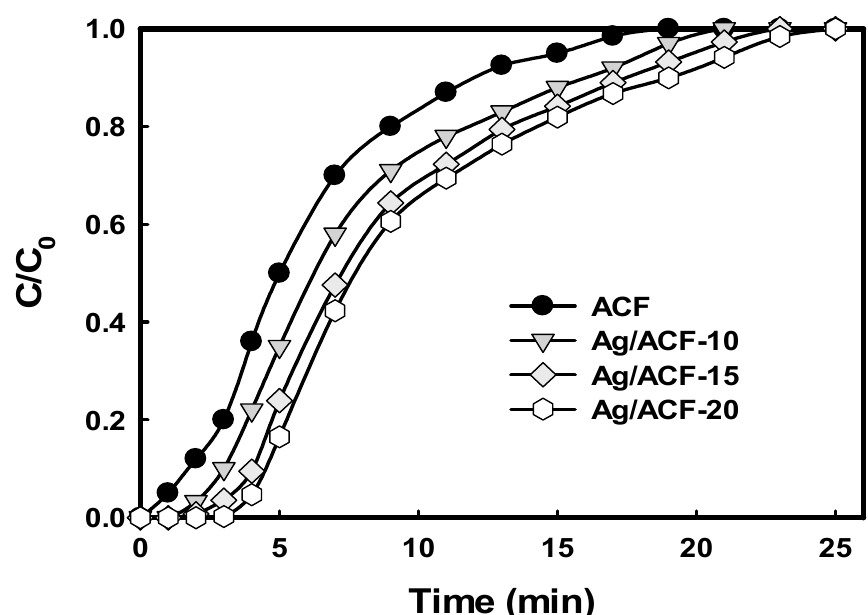
Figure 7. Acetaldehyde adsorption breakthrough curves of ACF and Ag/ACF composites.